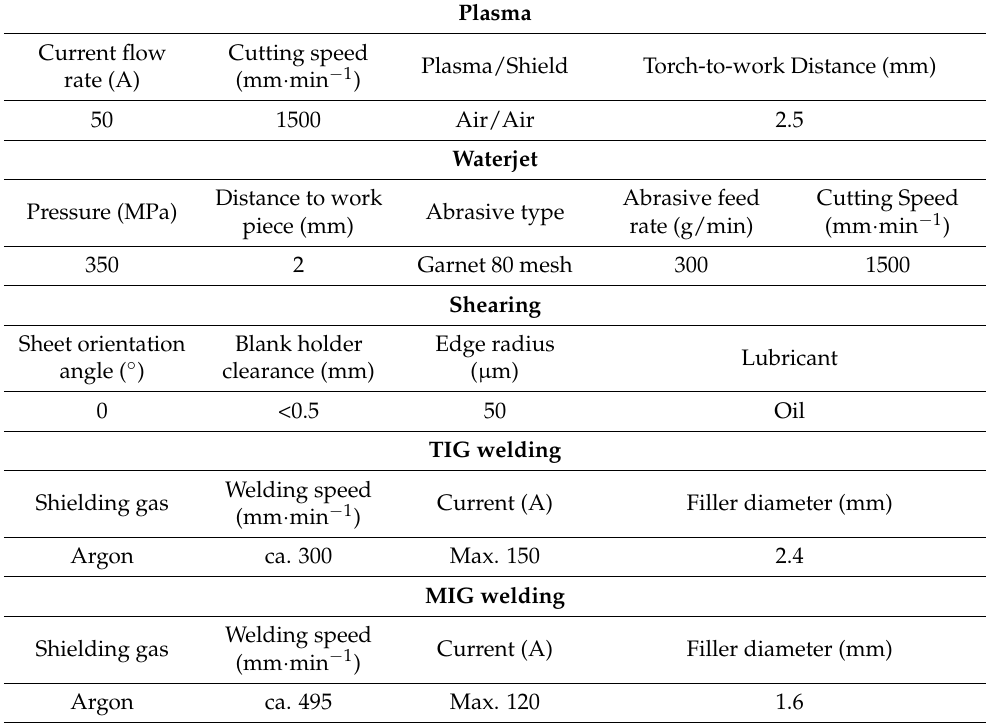
Table 2. Cutting and welding